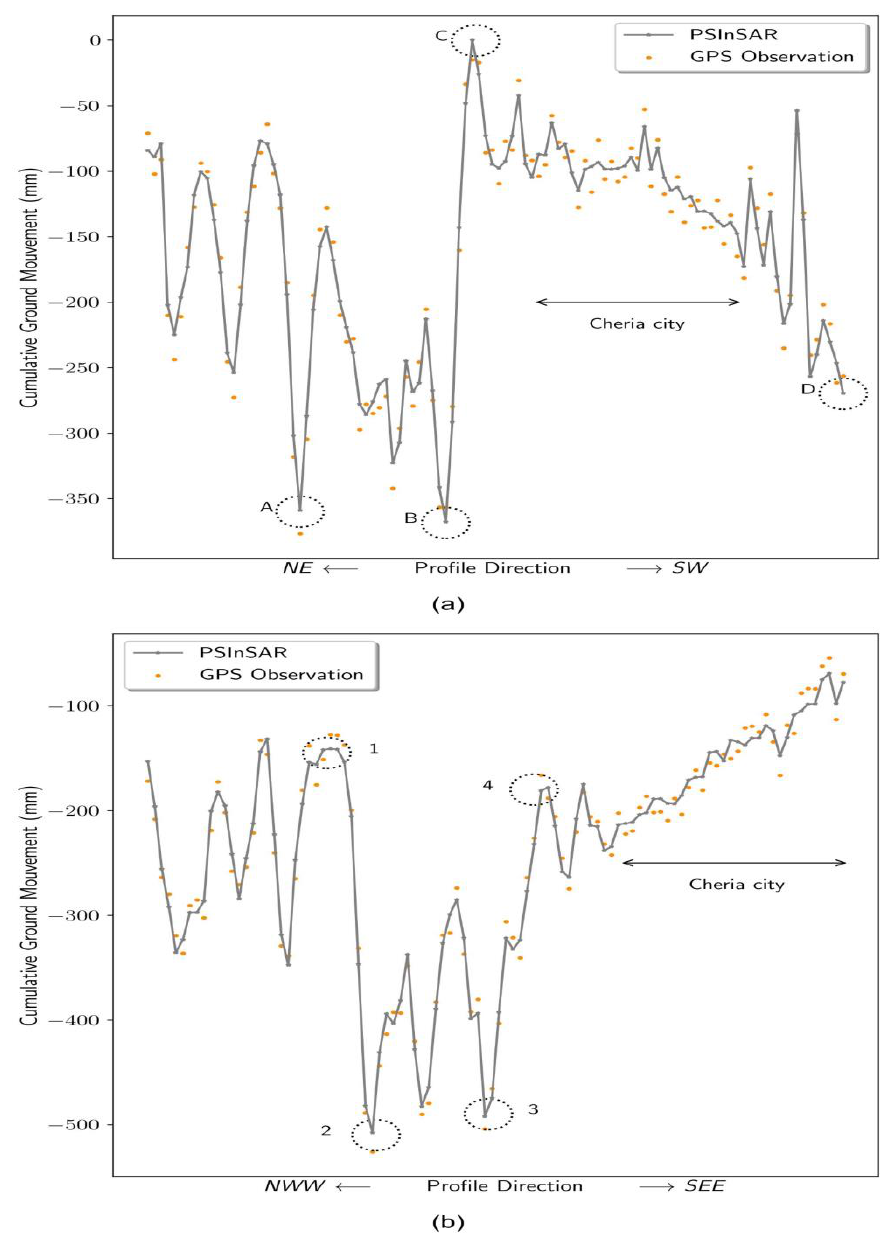
Figure 7. Cumulative vertical ground movement profiles: ( a ) AB and ( b ) CD profiles. The x -axis in the figure represents the profile direction along NE – SW and NWW – SEE directions, while the y -axis represents the cumulative vertical ground movement (mm). The black circle referring to selected points A, B, C, and D through the AB profile, and 1, 2, 3, and 4 through the CD profile, are also presented in Figure 8.